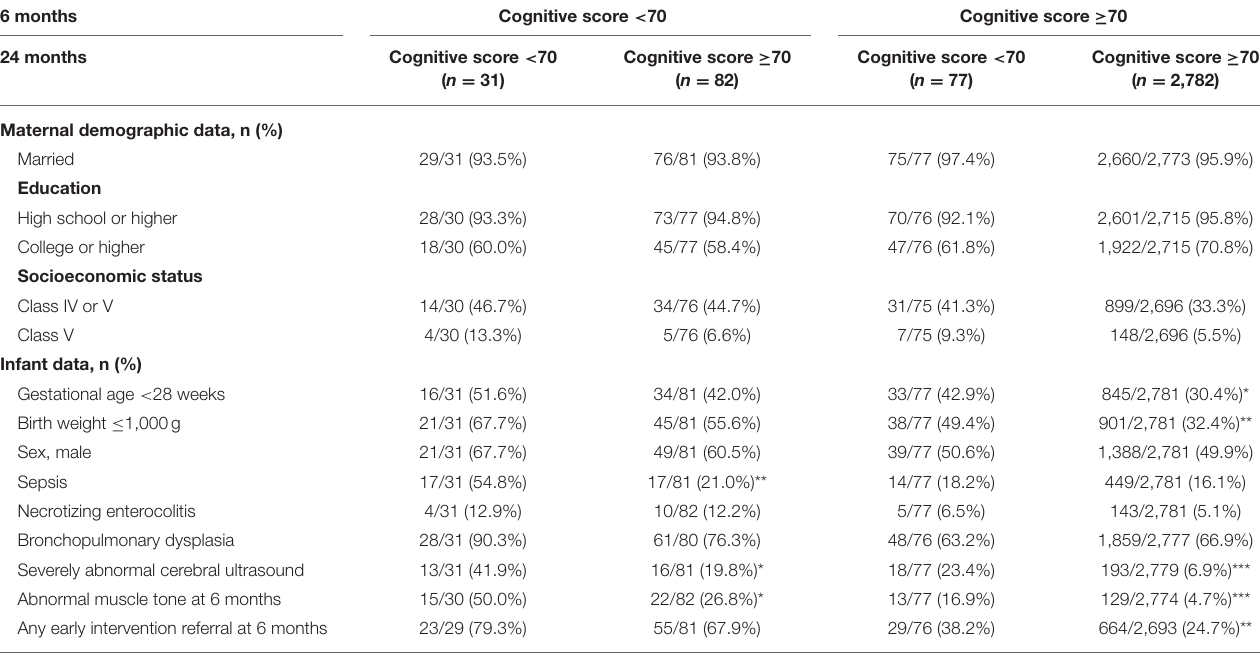
TABLE 3 | Comparison of maternal demographic and infant data according to change in cognitive scores from 6 to 24 months in cut-off score of